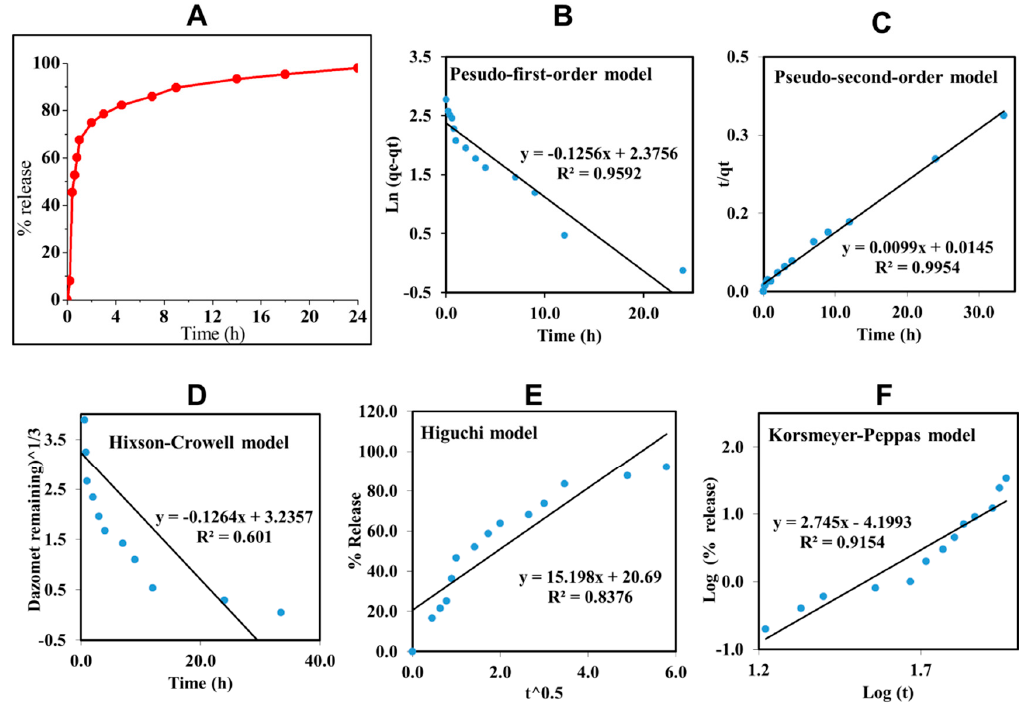
Figure 6. Cumulative release profiles of dazomet from CDEN5 nanoparticles at pH 5.5 ( A ) and their fitting of the data using five different mathematical models at pH 5.5 ( B – F ).